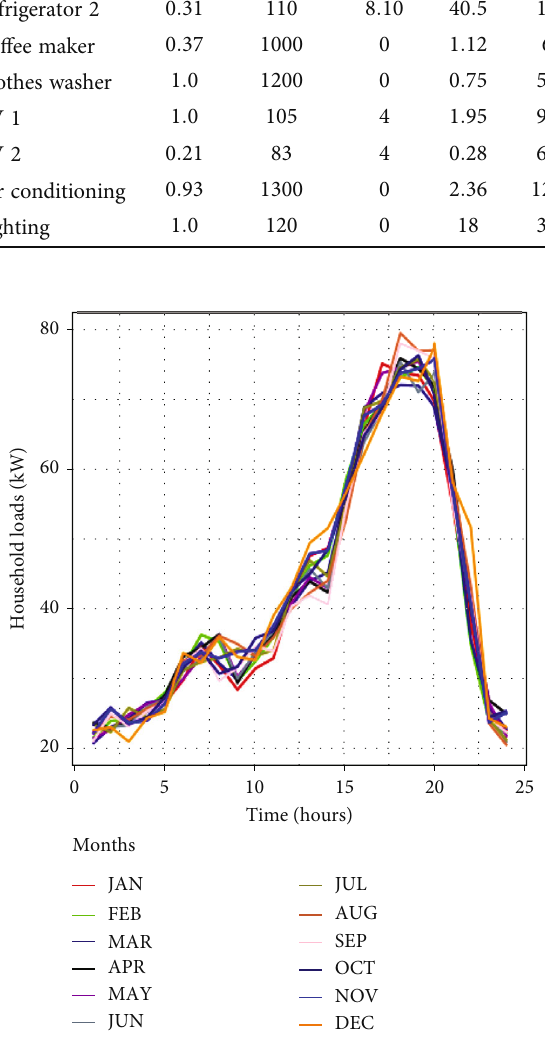
Figure 12: Household load demand.